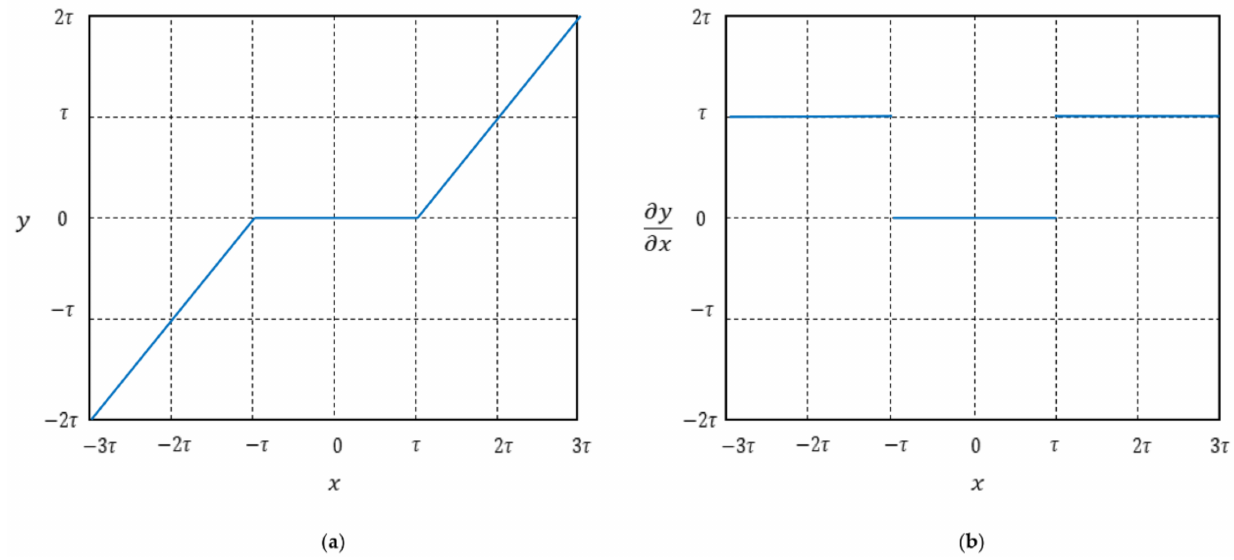
Figure 2. Soft thresholding and its derivative: ( a ) soft thresholding; ( b ) derivative of the soft